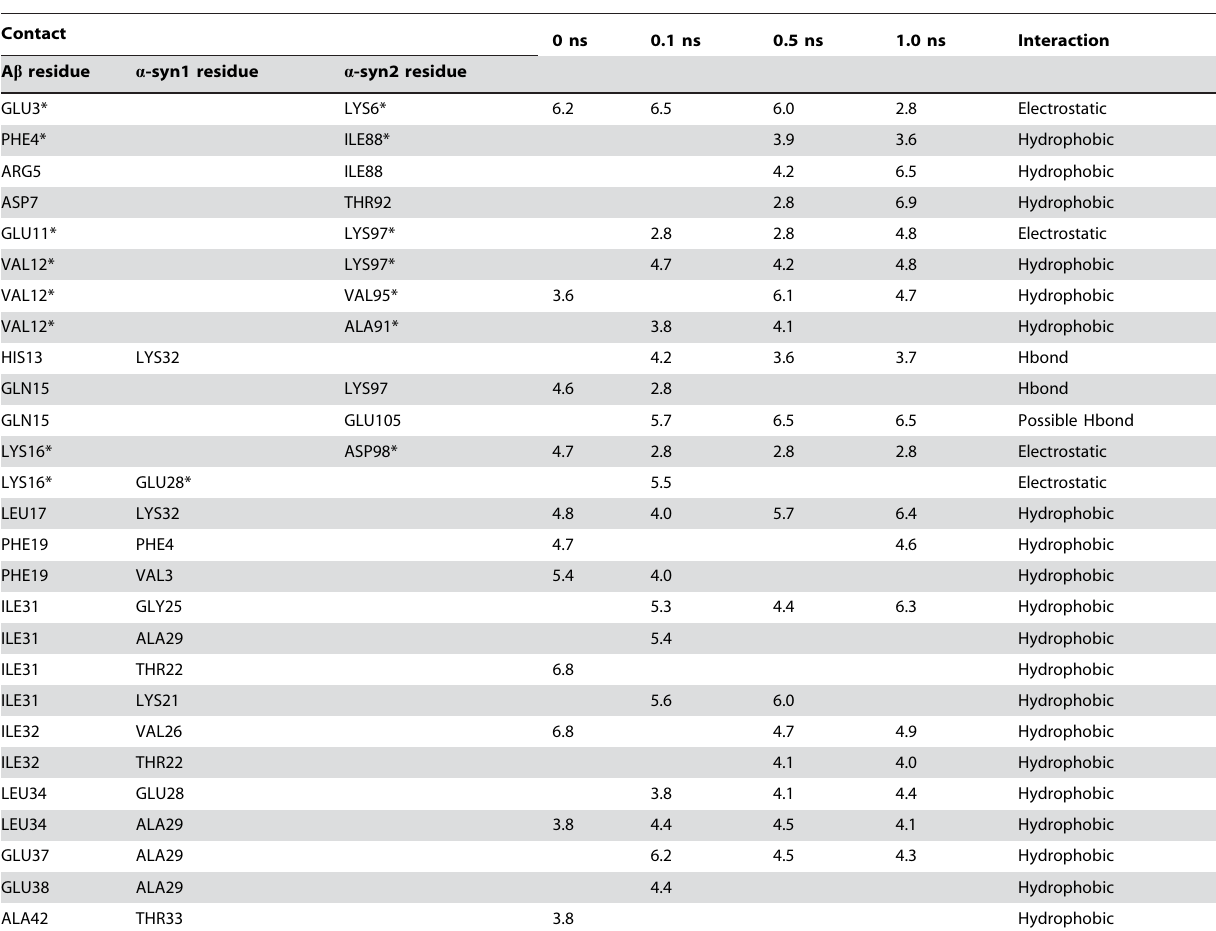
* Indicates residues located at the points predicted to be critical for stabilization of the A b - a -syn complexes on the membrane. These resides of A b were mutated for additional analysis of A b - a -syn interactions.